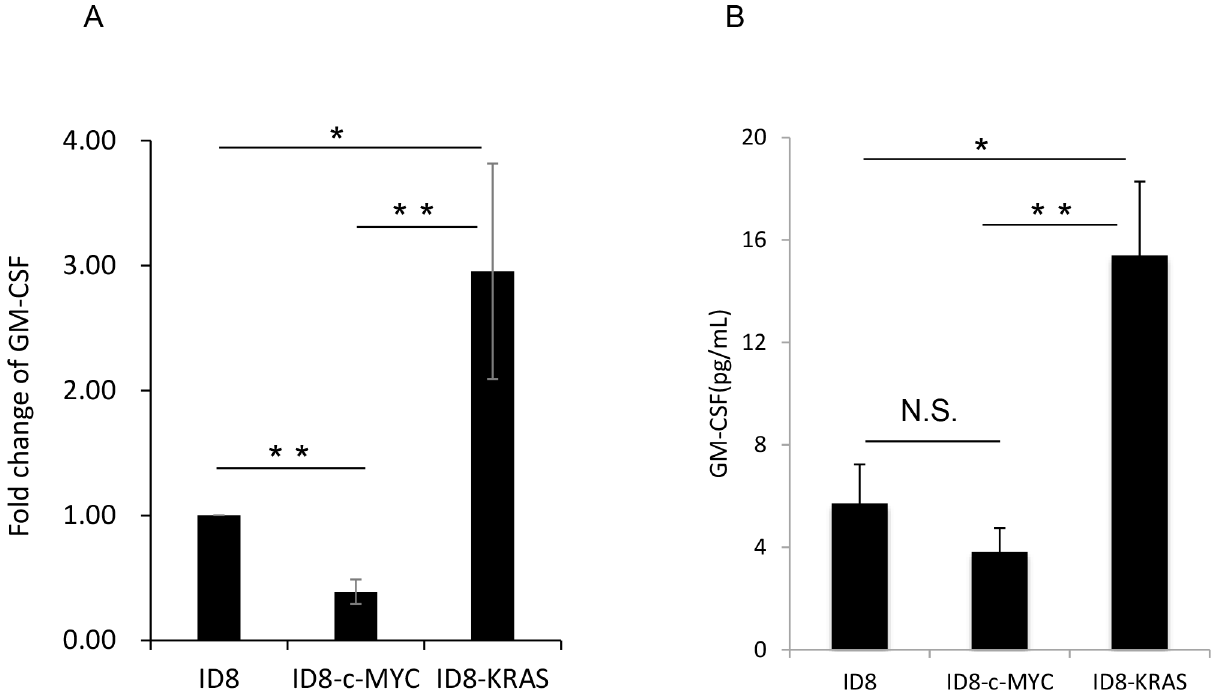
Fig 6. Granulocyte Macrophage Colony-stimulating Factor (GM-CSF) expression. (A) ID8, ID8-c-MYC, and ID8-KRAS cells were plated on 12-well culture plates at a concentration of 2×10 6 cells/ml and cultured for 48 h, and total RNA was extracted followed by revers transcription. GM-CSF mRNA levels were assessed using a quantitative reverse transcription polymerase chain reaction. The expression of GM-CSF was normalized using PPIA mRNA as the internal standard. Expression levels were calculated by the comparative Ct method using PPIA as an endogenous reference gene. Data are the mean ± standard error of the mean (SEM) of three independent experiments. Data were analyzed using the Student ’ s t-test ( * P (cid:1) 0.05, ** P (cid:1) 0.01). (B) ID8, ID8-c-MYC, and ID8-KRAS cells were plated on 12-well culture plates at a concentration of 2×10 6 cells/ml and cultured for 48 h. The concentrations of GM-CSF protein levels were assessed using specific ELISA. Error bars represent the mean ± SEM. A statistical analysis was performed with the Student ’ s t-test ( * P (cid:1) 0.05, ** P (cid:1) 0.01, n.s. indicates not